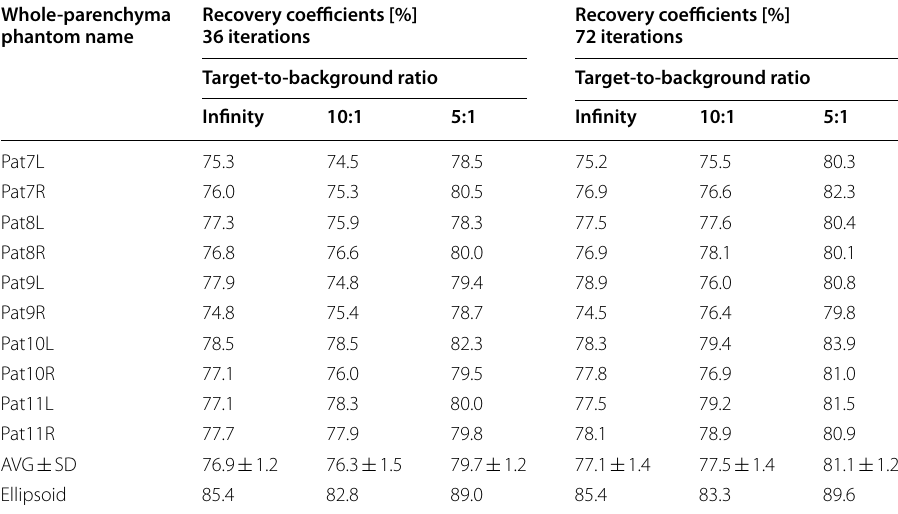
The AVG SD row denotes the average plus/minus one standard deviation of all whole-parenchyma phantoms RCs. The ± last line contains the RCs of the ellipsoidal phantom for comparison. Values were obtained for LEHR collimation and the radionuclide 99m Tc